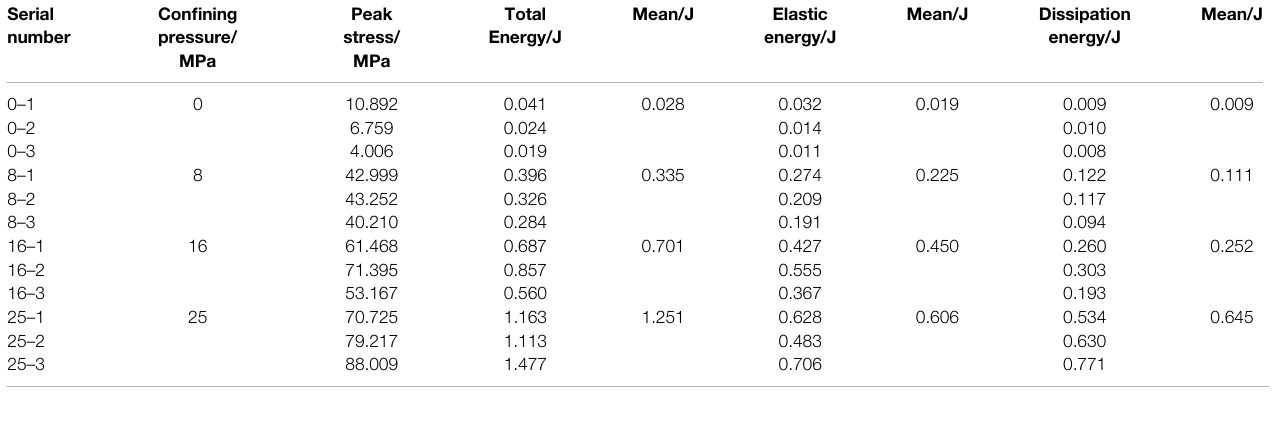
TABLE 3 | Energy characteristics of peak stress of coal rock.